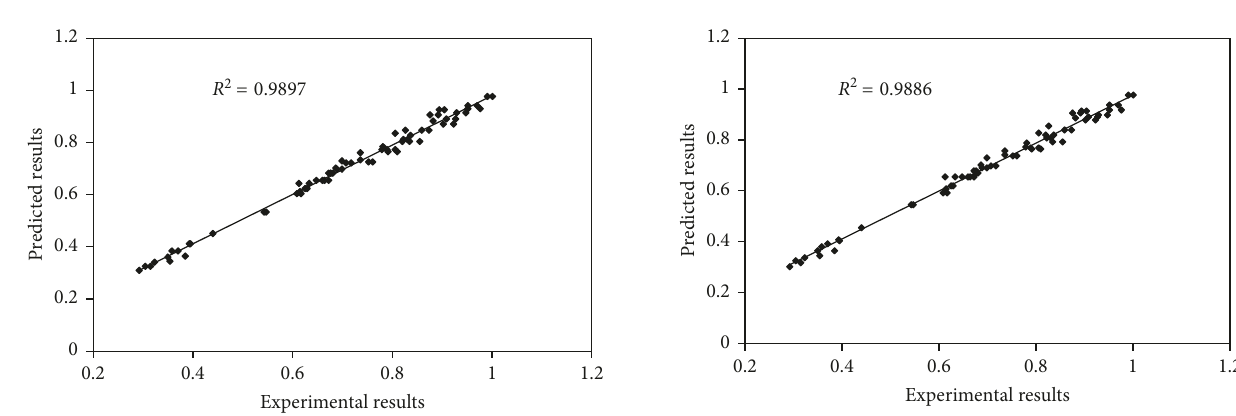
Figure 17: Linear relationship between measured and predicted compressive strengths for the one-step secant backpropagation algorithm of ANN.